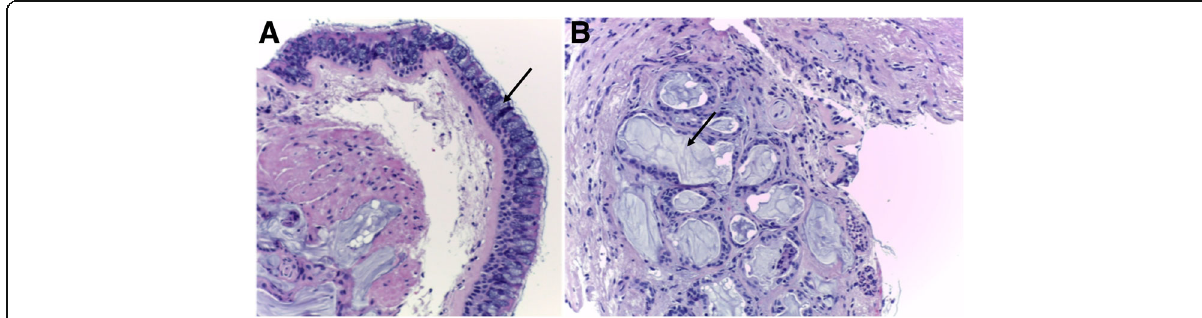
Fig. 1 Chronic bronchitis. a and b Low-power hematoxylin and eosin stain (H&E) shows an increased number of goblet cells (arrow in a ) and hyperplasia of submucosal glands (arrow in b ). Hypersecretion of mucus from goblet cells is also visualized